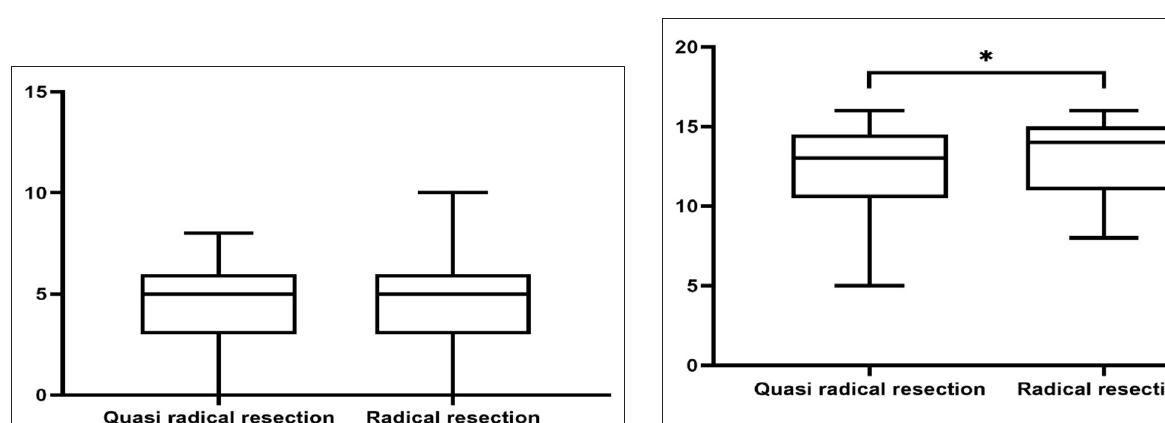
FIGURE 3 | Physical domain.